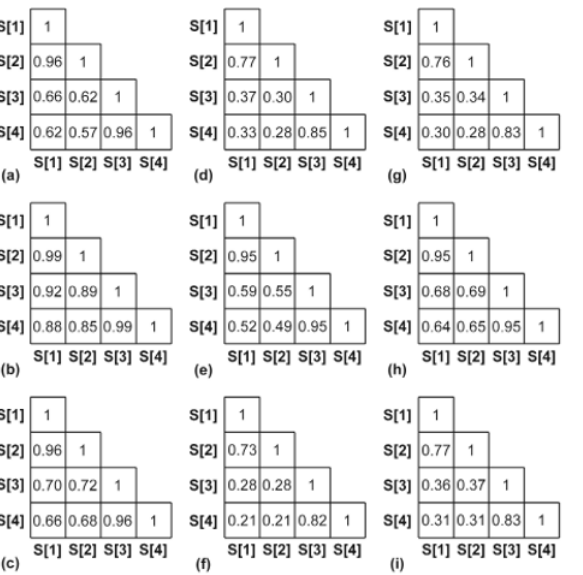
Figure 7. Nine matrices concerning the second subgroup of pharmacophores: ( a ) the ( N-A ) – ( N-A-C ), ( b ) the ( N-A ) – ( N-C-A ), ( c ) the ( N-A ) – ( A-N-C ), ( d ) the ( N-C ) – ( N-A-C ), ( e ) the ( N-C ) – ( N-C-A ), ( f ) the ( N-C ) – ( A-N-C ), ( g ) the ( A-C ) – ( N-A-C ), ( h ) the ( A-C ) – ( N-C-A ) and ( i ) the ( A-C ) – ( A-N-C )